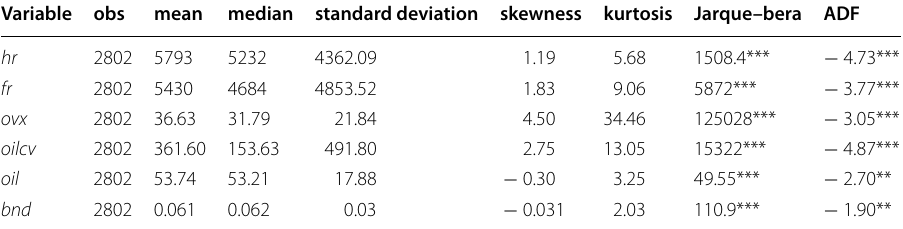
Table 2 Summary statistics for the variables and JB, ADF test